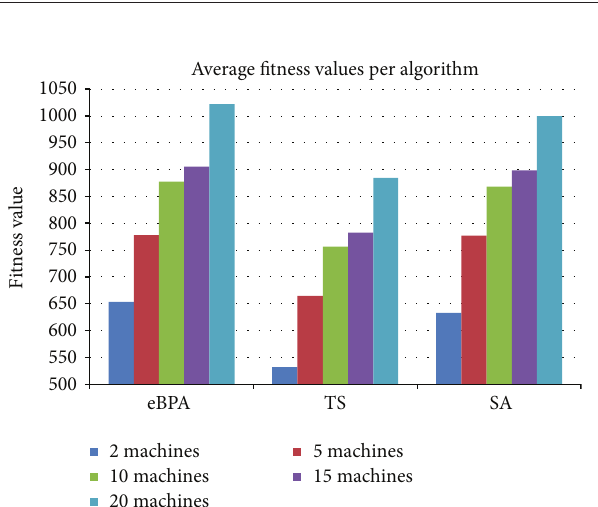
Figure 7: BFV comparisons for the class of 2,500 jobs.